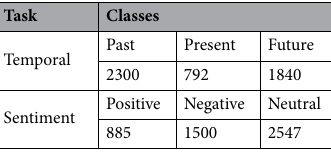
Table 3. Data distribution over various temporal categories and sentiment classes.